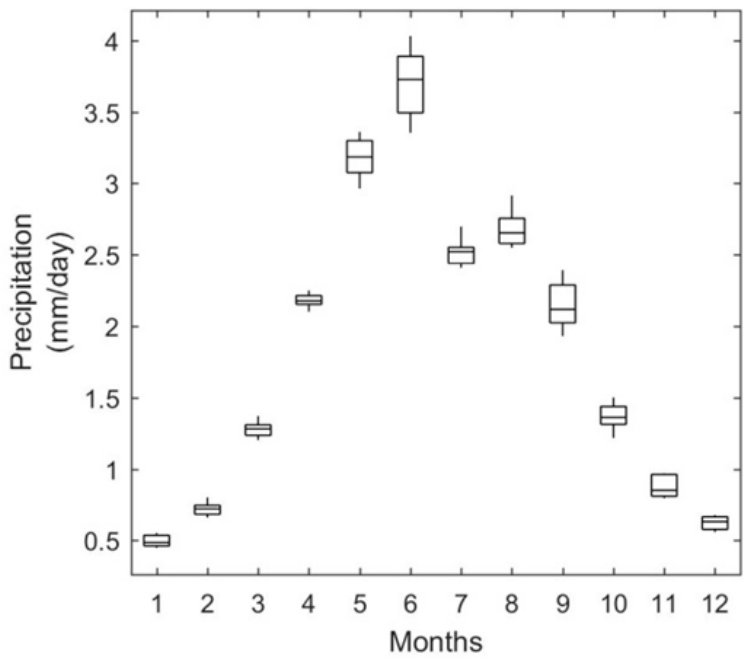
Figure 2. Historical monthly average, 25th and 75th quantiles, and minimum and maximum precip- itation [mm/day] for the Shell Creek watershed between 1910 and 2014.